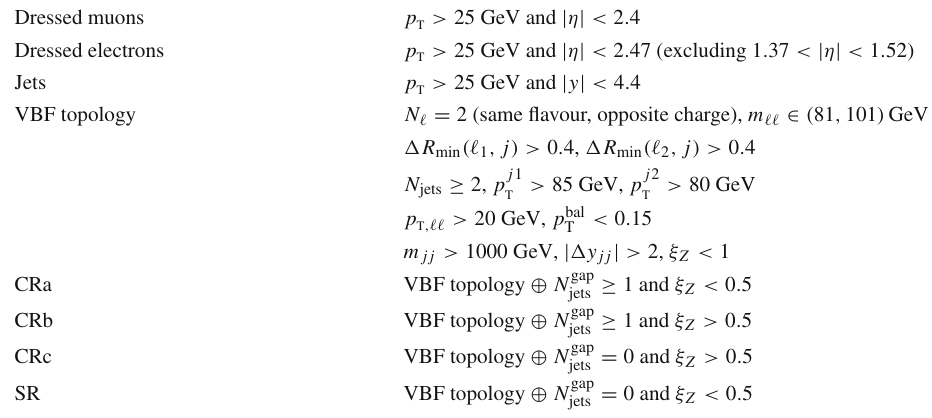
Table 3 Particle-level definition of the measurement. (cid:4) R ((cid:3) , j ) denotes the min 1 minimum (cid:4) R distance between the highest transverse-momentum